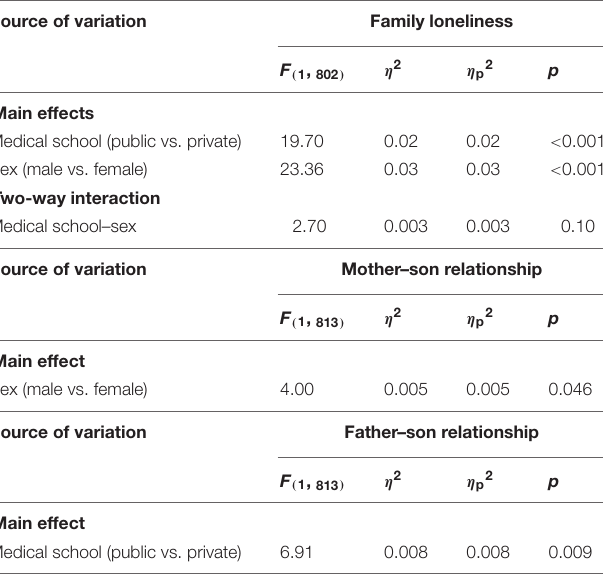
TABLE 4 | ANOVA of family loneliness and mother–son and father–son relationships by medical school and sex, as sources of